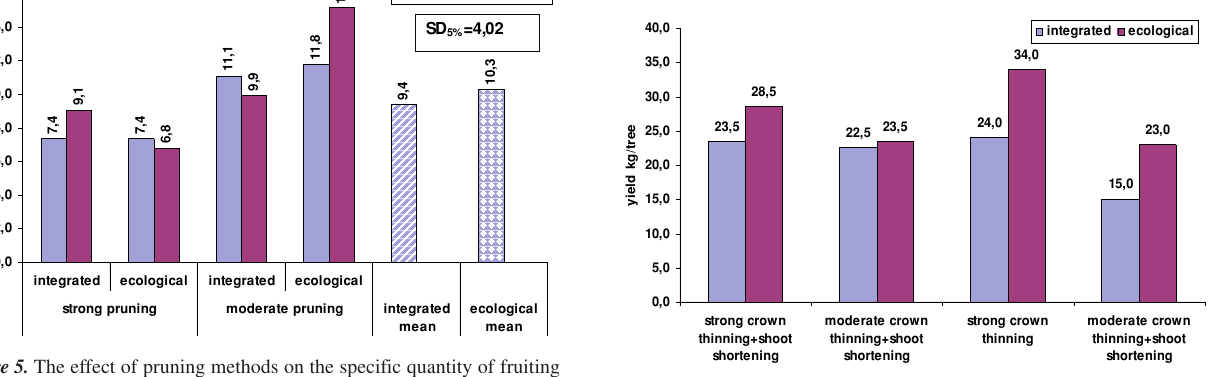
Figure 7. Consequence of the intensity and method of pruning on ‘Idared’ apple trees grafts of M 26 expressed in the fruit load of the next year (Debrecen-Pallag 2009)